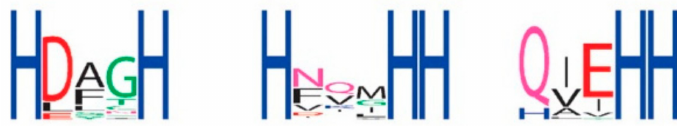
Figure 2. Sequence logo of histidine boxes in membrane associated front-end desaturases such as ∆ 6 Fads2. The high of letters corresponds to the occurrence probability. Adapted from (Sayanova, 2001). Modified after (Hashimoto,